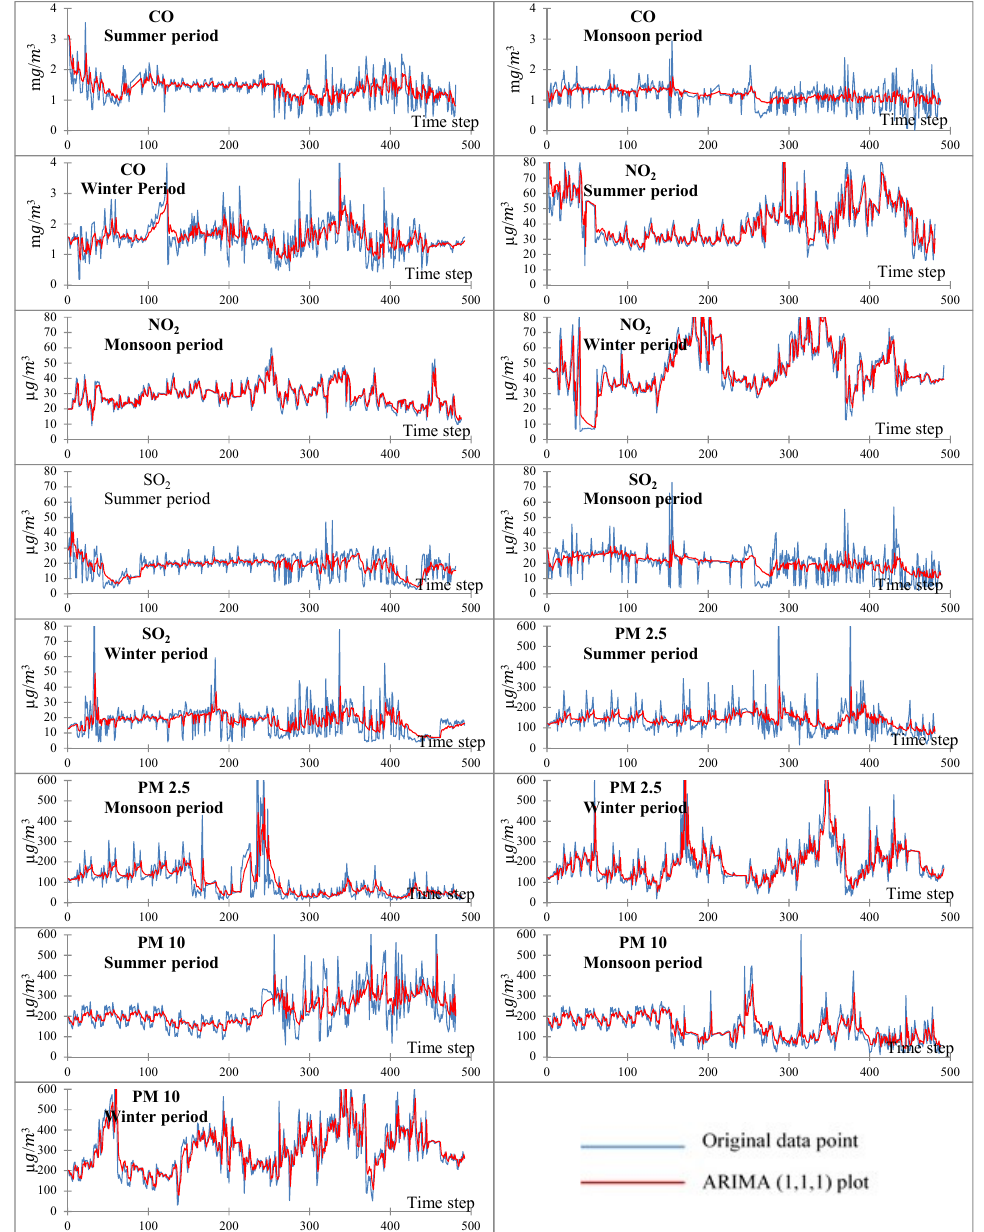
Fig. 3: Pollutants original data point and ARIMA (1,1,1) plot for different seasons from the year 2013 to 2016 of